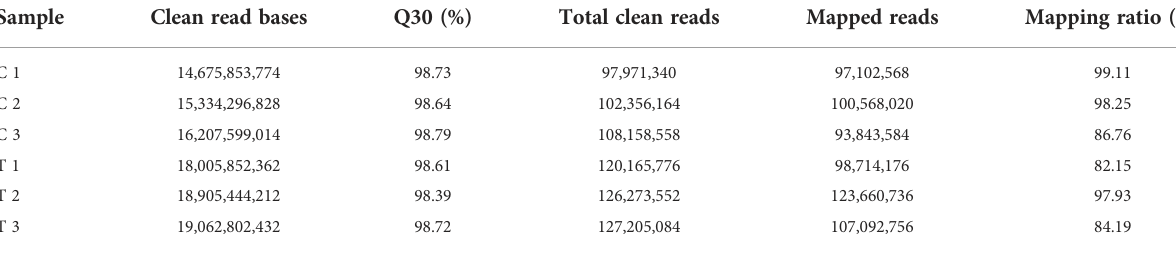
TABLE 2 Summary of the reads of circRNA libraries after quality control. Sample